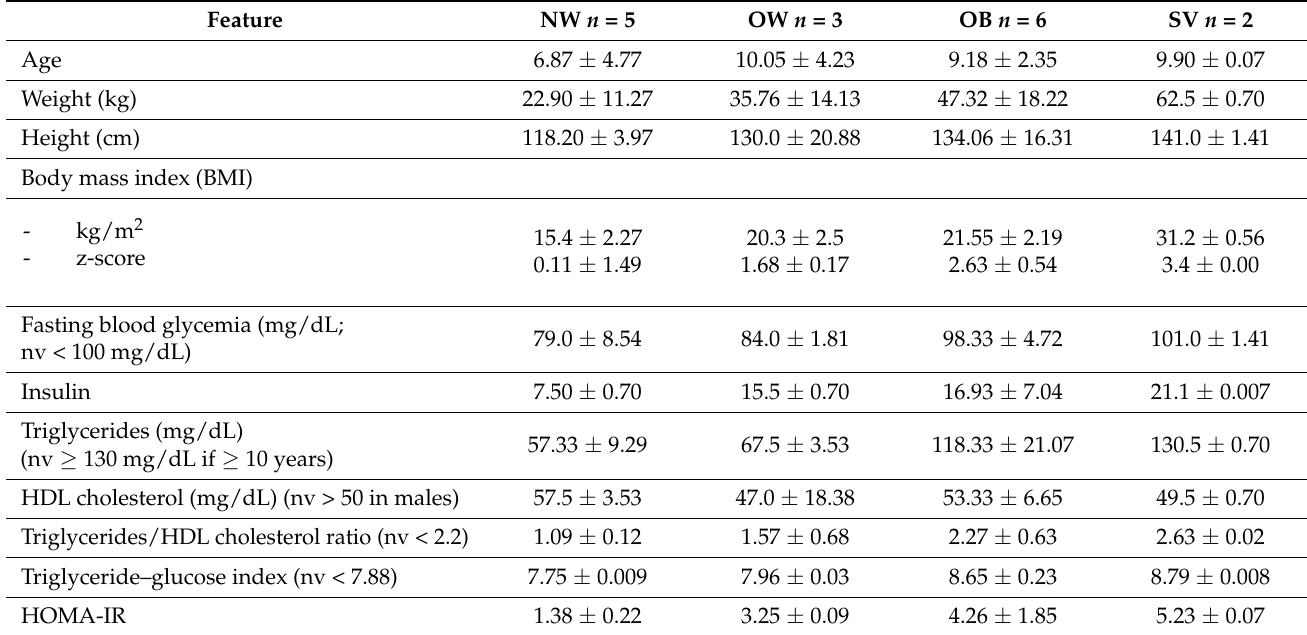
Table 1. Clinical and biochemical features of subjects whose scAT was considered for RNA extraction and RNA-seq study. nv: normal value. p -value <